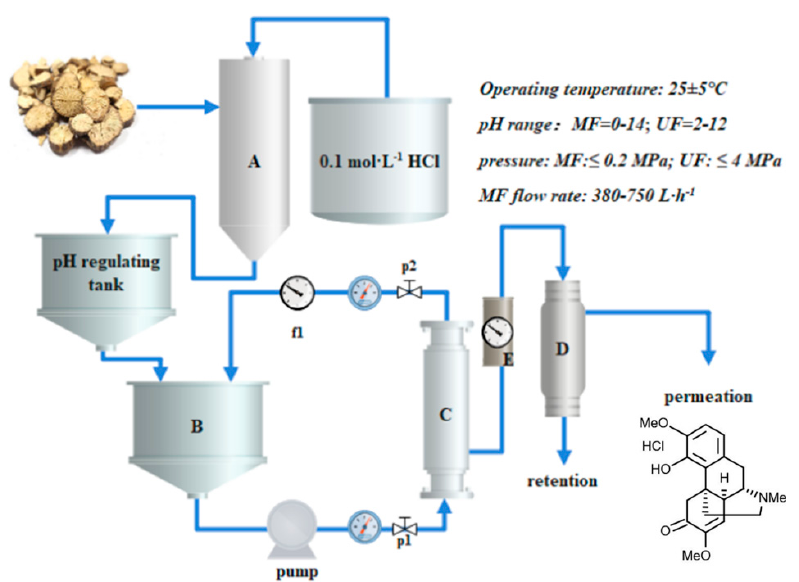
Figure 1. Separation and purification flow chart of Caulis sinomenii extract solution. ( A ) percolation tank; ( B ) feed tank; ( C ) ceramic MF membrane module; ( D ) UF membrane module; ( E ) metal tube rotameter.